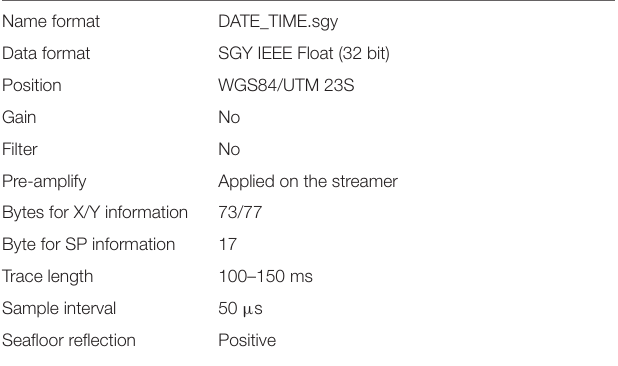
TABLE 1 | Summary of SGY data